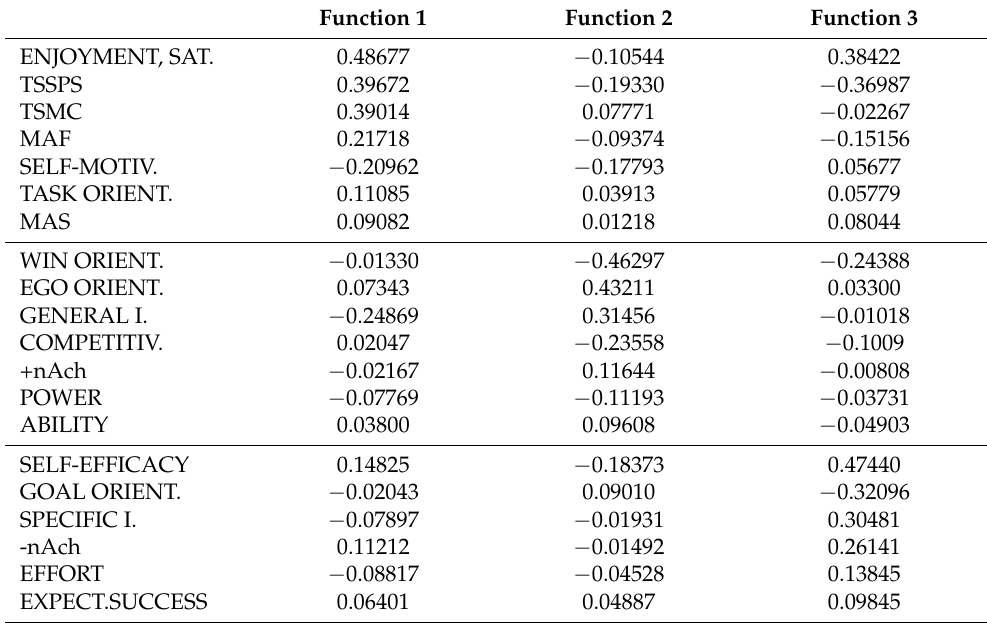
Table 3. Structure matrix.